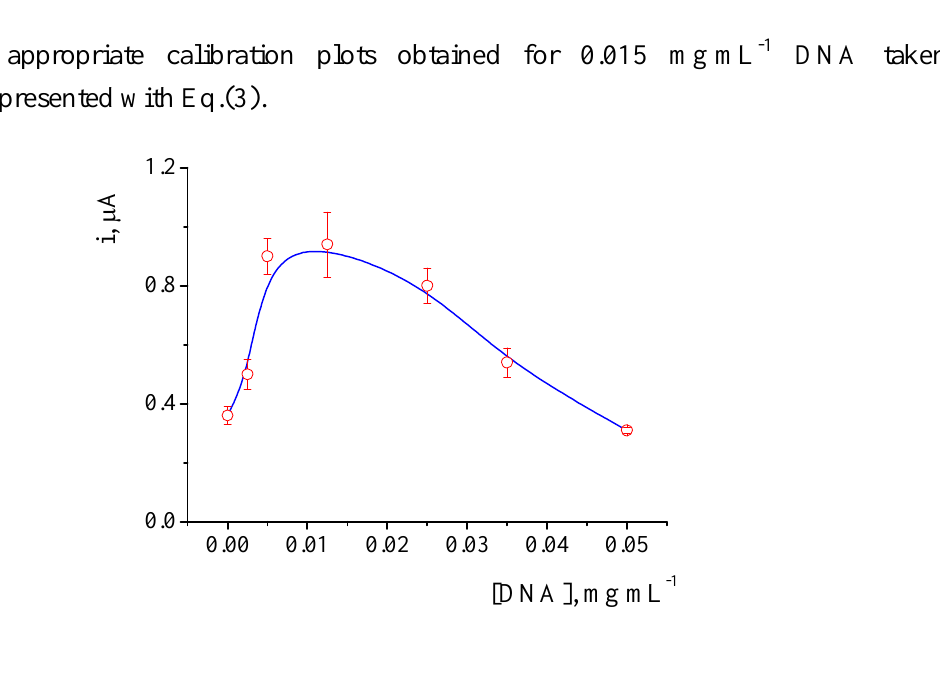
Figure 1. The dependence of the signal of the DNA-HRP sensor on the concentration of solution used for DNA immobilization, 0.4 µ mol L -1 MB, 2.0 mmol L -1 H